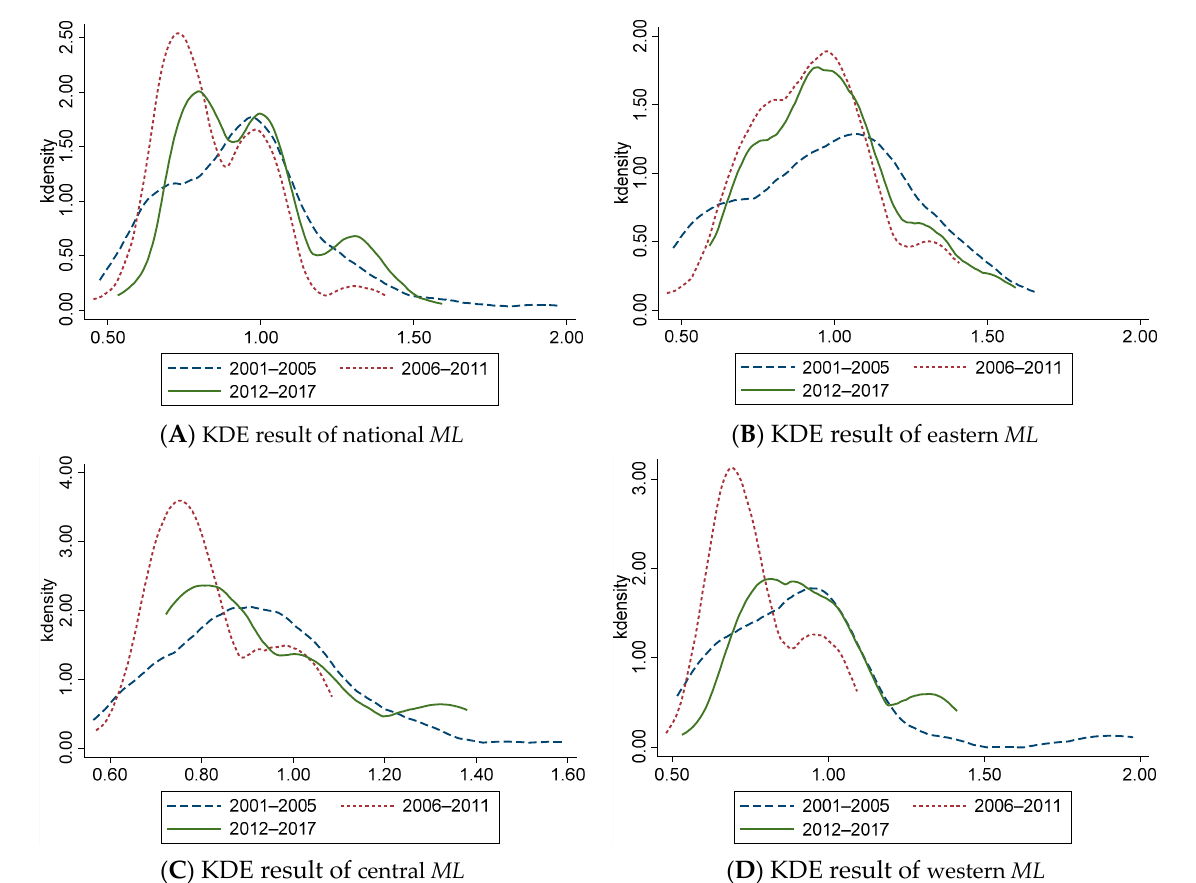
Figure 1. The Kernel Density Estimation Results of ML of China’s Logistics Industry. ( A ) KDE result of national ML ( B ) KDE result of eastern ML ( C ) KDE result of central ML ( D ) KDE result of western ML.